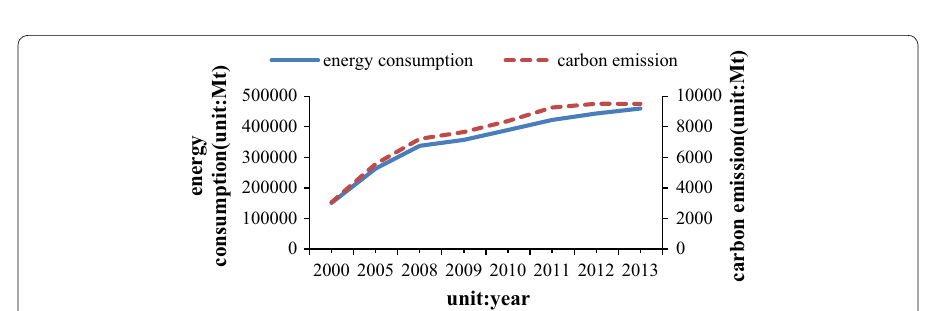
Fig. 2 The total value of carbon emission and energy consumption in China from 2000 to